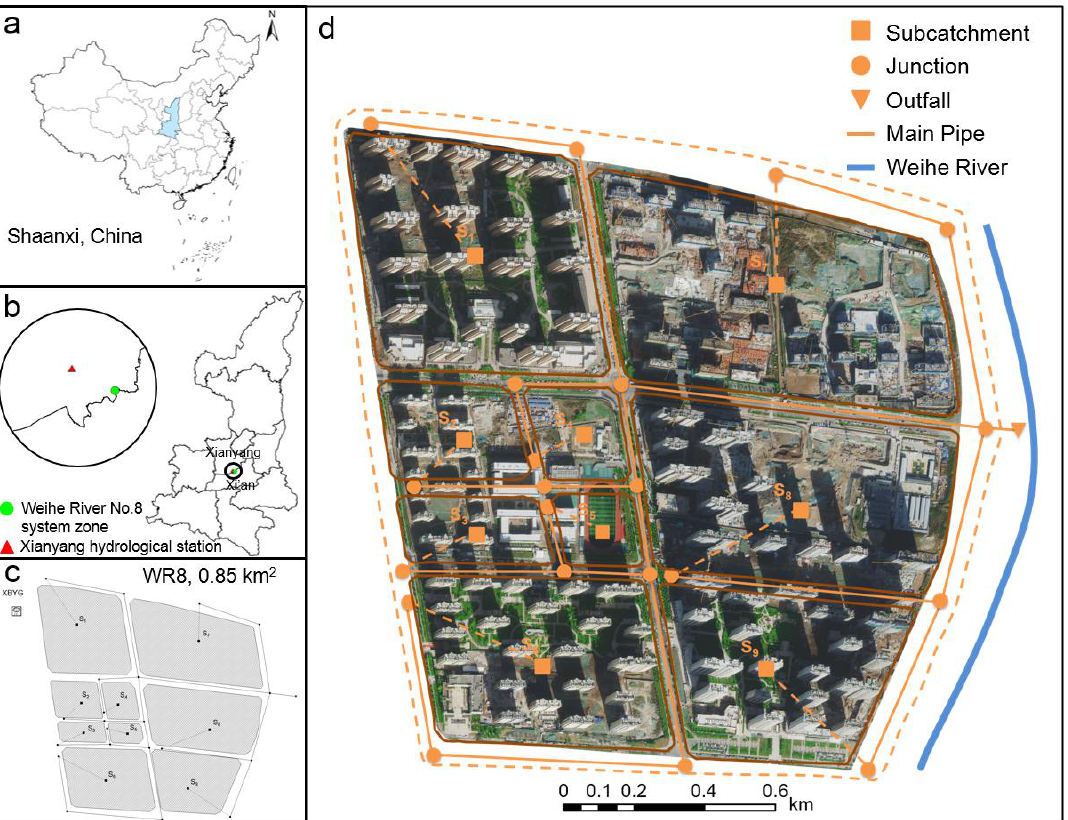
Figure 1. Map of the study area for simulation: ( a ) Shannxi Province, China; ( b ) Weihe River No. 8 system zone (WR8), Fengxi New City; ( c ) Study area map of WR8 in storm water management model; and ( d ) Aerial photographs of